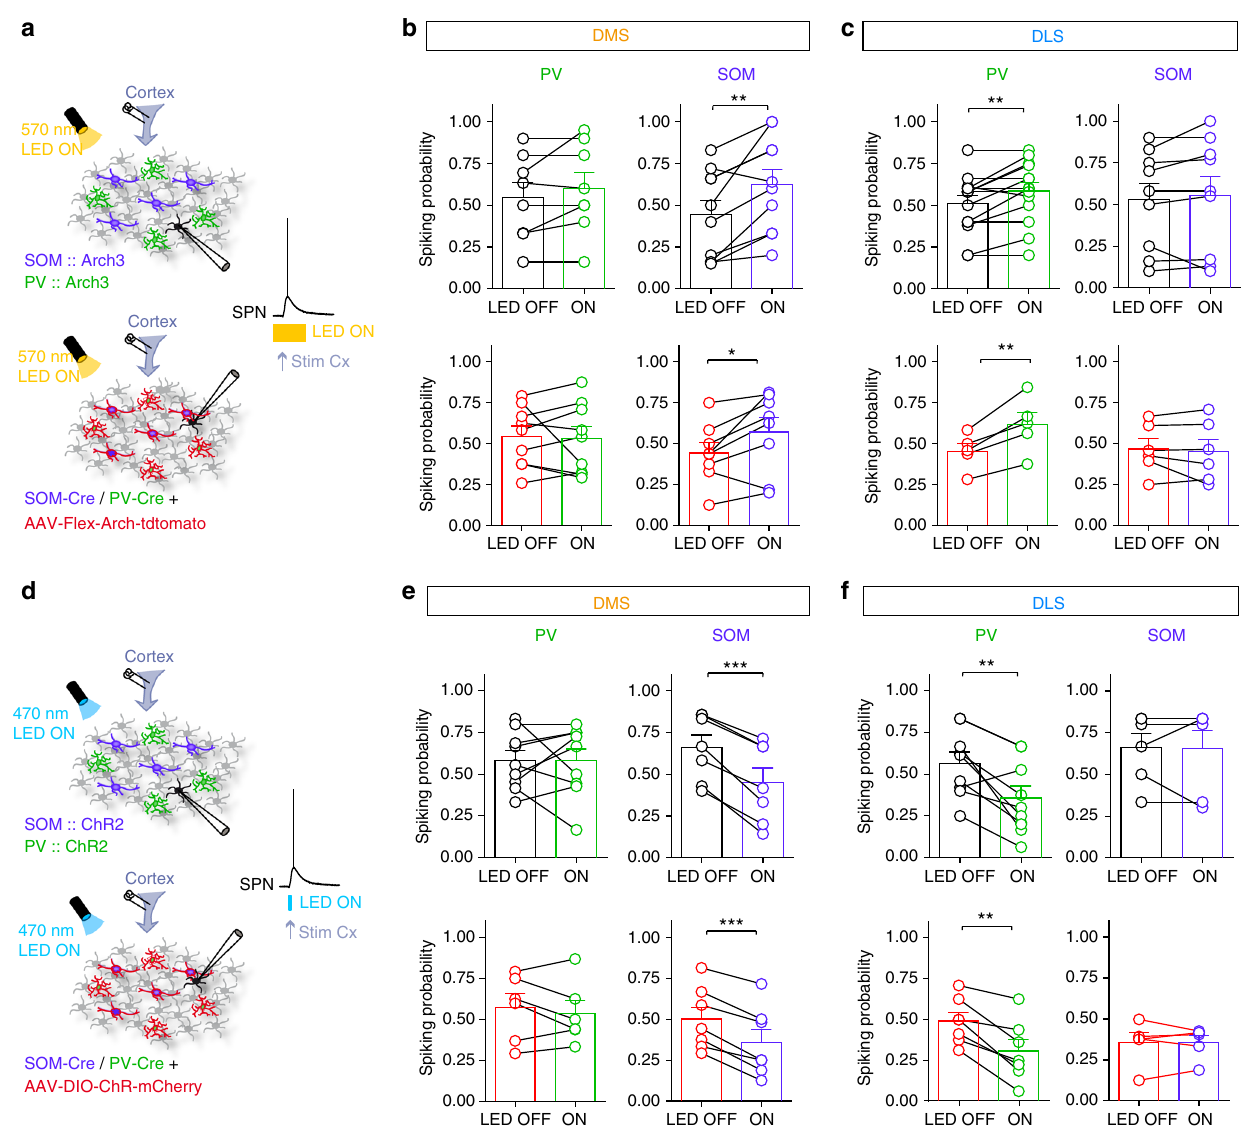
Fig. 3 Selective modulation of cortically-evoked spiking activity by SOM and PV cells. a Experimental set up: electrical stimulations were applied in the cortex and evoked APs were recorded in SPNs, in control or with speci fi c opto-inhibition of PV cells or SOM cells in transgenic mice PV::Arch3 and SOM:: Arch3 (top) or PV-Cre and SOM-Cre mice virally infected with AAV-Flex-Arch-tdtomato (bottom) (Arch3 activation for 300 ms with a 570 nm LED). b , c The spiking probability of SPNs was compared between interleaved control and opto-inhibition conditions in DMS ( b ) and DLS ( c ) using transgenic mice (top, black) or virally infected interneurons (bottom). Individual experiments and averaged (mean ± SEM) normalized spiking probability are represented. Opto-inhibition of SOM cells leads to a signi fi cant increase in spiking probability in DMS ( n = 15, p = 0.0063 for transgenic and n = 8, p = 0.033 for virus experiments) and no difference in DLS ( n = 10, p = 0.2567 for transgenic and n = 6, p = 0.55479 for viruses). For PV cells, the effect is opposite, opto-inhibition of PV cells signi fi cantly increase the spiking probability in DLS ( n = 16, p = 0.0288 for transgenic and n = 5, p = 0.0063 for viruses), while their opto-inhibition has no effect in DMS ( n = 7, p = 0.1854 for transgenic and n = 9, p = 0.8007 for viruses). d Experimental set up: electrical stimulations were applied in the cortex and evoked APs were recorded in SPNs, in control or with speci fi c opto-activation of PV cells or SOM cells with ChR2 activation in transgenic mice PV::ChR2 and SOM::ChR2 (top) or PV-Cre and SOM-Cre mice virally infected with AAV-Flex-ChR-mCherry (bottom) (for 5 ms using a 470 nm excitation LED). e , f The spiking probability of SPNs was compared between the control and opto-activation conditions in DMS ( e ) and DLS ( f ) using transgenic mice (top, black) or virally infected interneurons (bottom, red). Individual experiments and averaged normalized spiking probability are represented. SOM opto-activation leads to a signi fi cant decrease in spiking probability in DMS ( n = 7, p = 0.0002 for transgenic mice and n = 7, p = 0.0002 for viral experiments) and no difference in DLS ( n = 6, p = 0.9114 for transgenic and n = 5, p = 0.9980 for viruses). Opto-activation of PV cells signi fi cantly decrease the spiking probability in DLS ( n = 9, p = 0.0059 for transgenic and n = 7, p = 0.0023 for viruses) but not in DMS ( n = 9, p = 0.9816 for transgenic and n = 6, p = 0.4518 for viruses). Paired tests, * p < 0.05, ** p < 0.01, *** p <